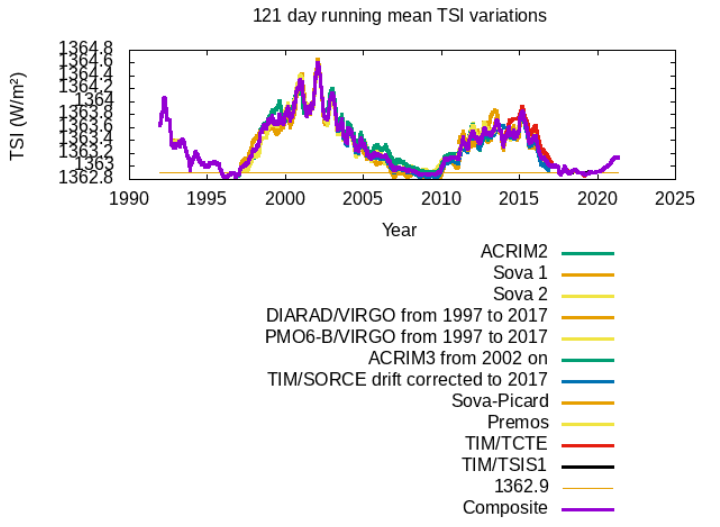
Figure 1. The 121 day running means of individual TSI instrument measurements and resulting com- posite after adjustment/homogenisation of the absolute level and quality control by intercomparison. The characteristics of the individual TSI time series are summarised in Table 2. Table 2. Characteristics of individual TSI instrument time series. The instrument acronyms are listed at the end of the